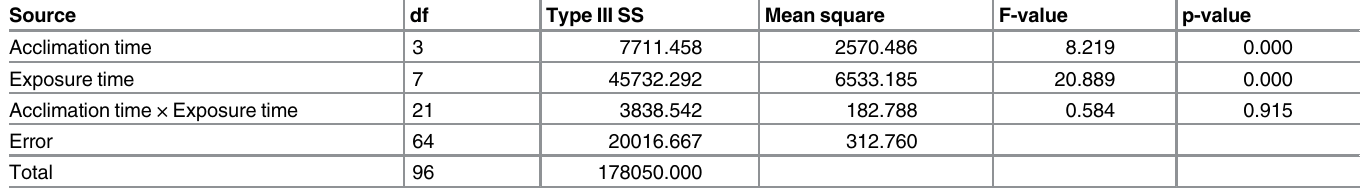
with acclimation was significantly lower than that of S . zeamais without acclimation (control) to sublethal high temperature, especially when the exposure times were 50, 60, 70, 80, 90, and 110 s at 55°C. The acclimation time and exposure time significantly affected the mortality of S . zeamais adults at p < 0.05 level, and the interaction between the acclimation time and exposure time had no significant effect on the mortality of S . zeamais adults (Table 8). Discussion The current study indicated that acclimation to sublethal high temperature could significantly enhance the survival of S . zeamais adults subsequently exposed to lethal high temperatures and reduce their mortality. In other words, acclimation to sublethal high temperature significantly enhanced the heat tolerance level of S . zeamais adults and reduced their subsequent susceptibil- ity to lethal high temperatures. Table 6. Two way analysis of variance (ANOVA) parameters for main effects and associated interactions for the mortality of S . zeamais exposed to 51°C. Source